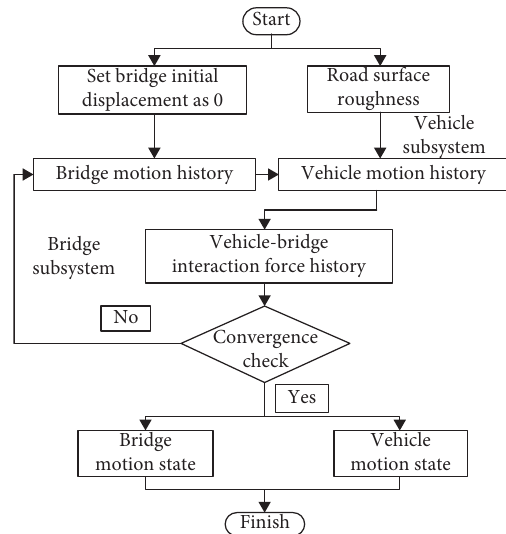
Figure 5: Flowchart of interhistory